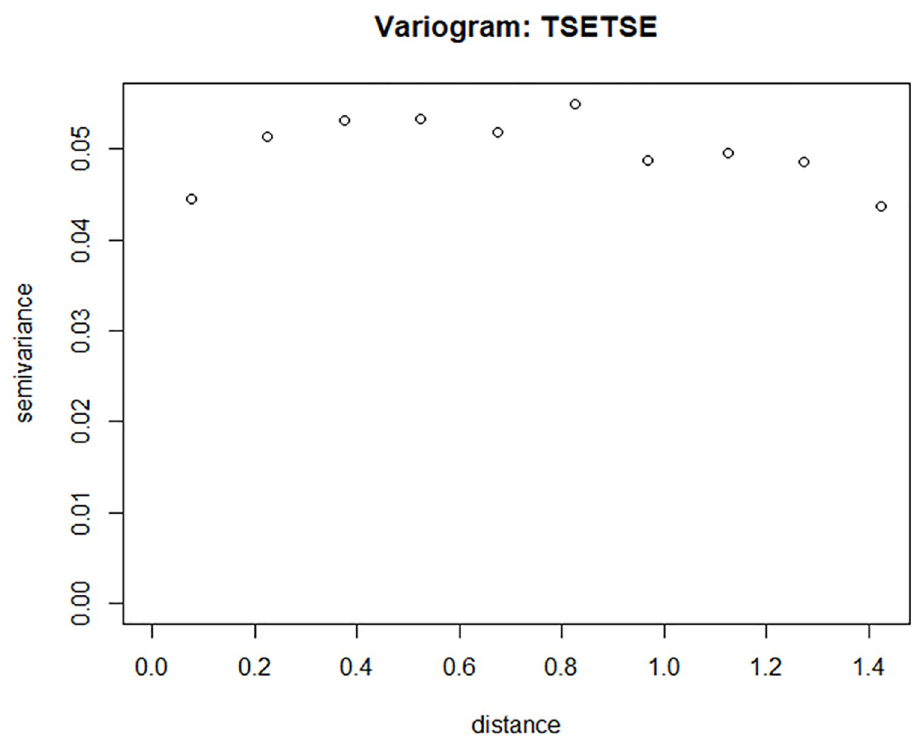
Fig 10. Residual variogram of the Pearson residuals based on the ZIP regression model (largely reveals the spatial independence of the residuals). This Residual variogram is an output from model fitting using R-tool under Zero- inflated Poisson